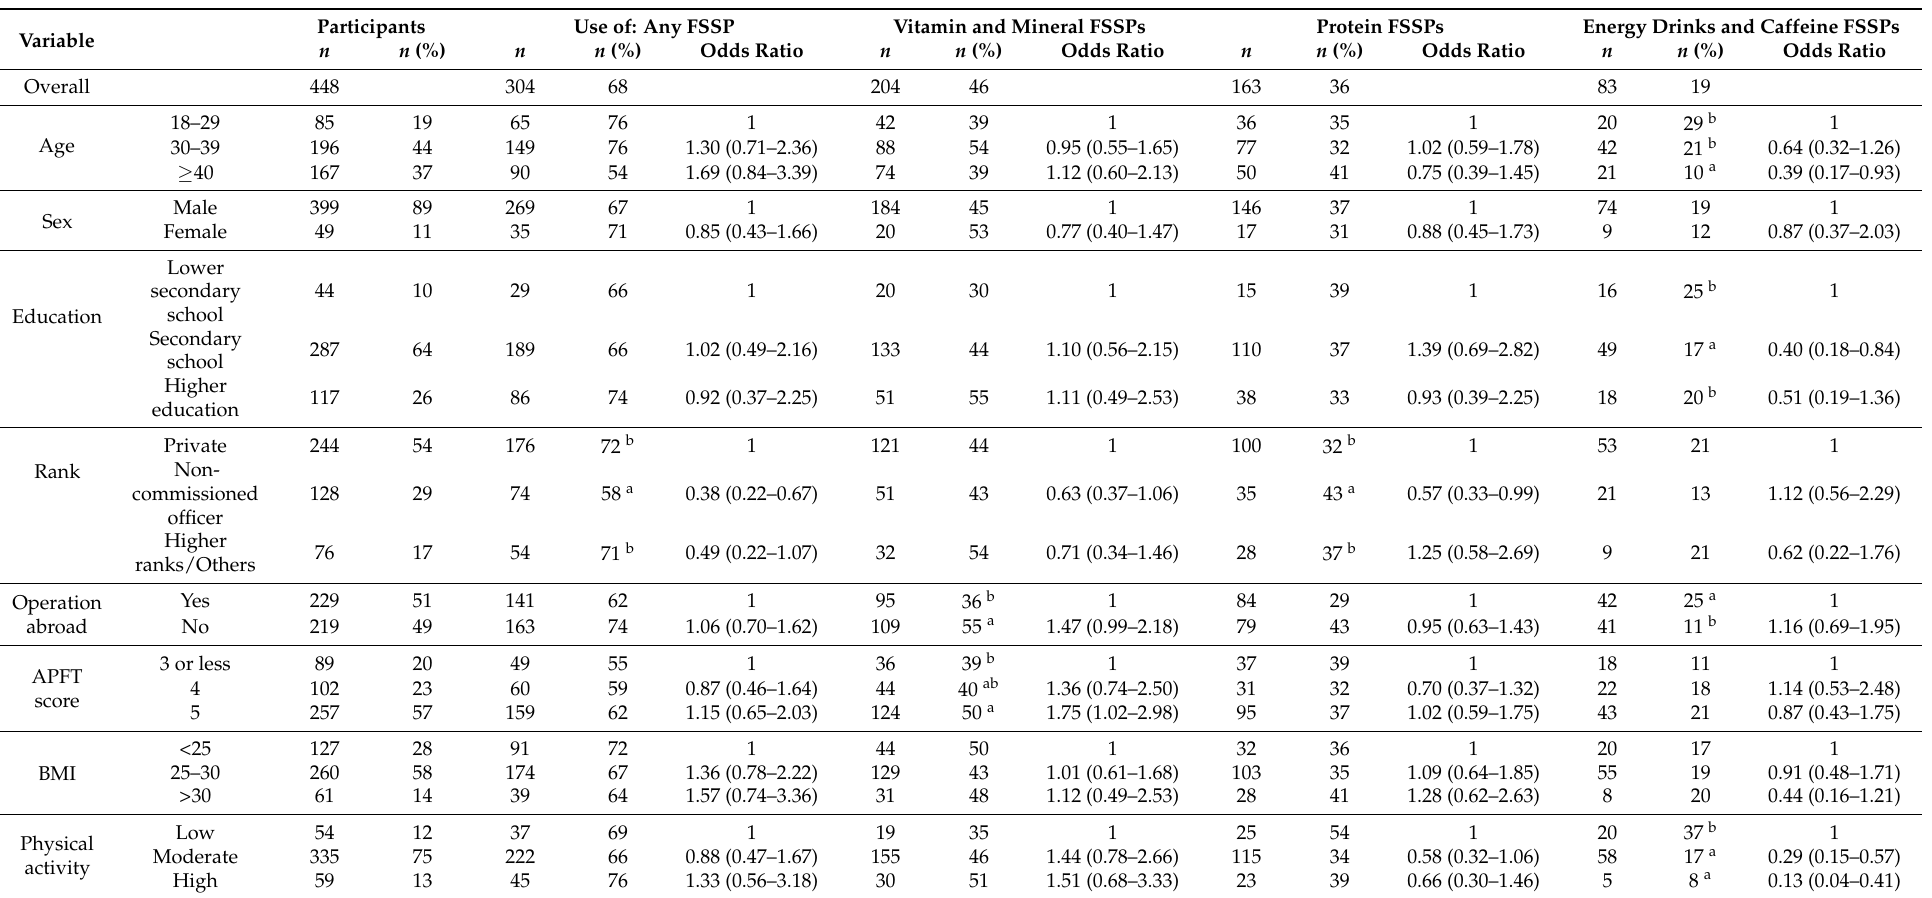
Table 1. Prevalence of use of food supplements and similar products (FSSPs) and odds ratios (95% confidence interval) for study participants recruited from the Slovenian Armed Forces ( n =